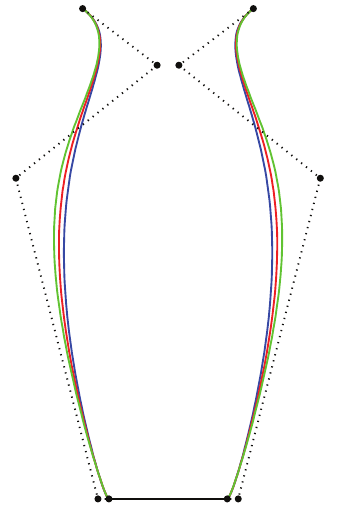
Figure 6: Three kinds of outlines of the